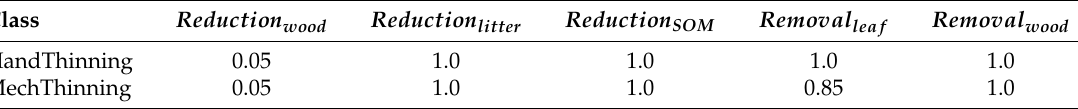
Table A14. Harvest reduction parameters;